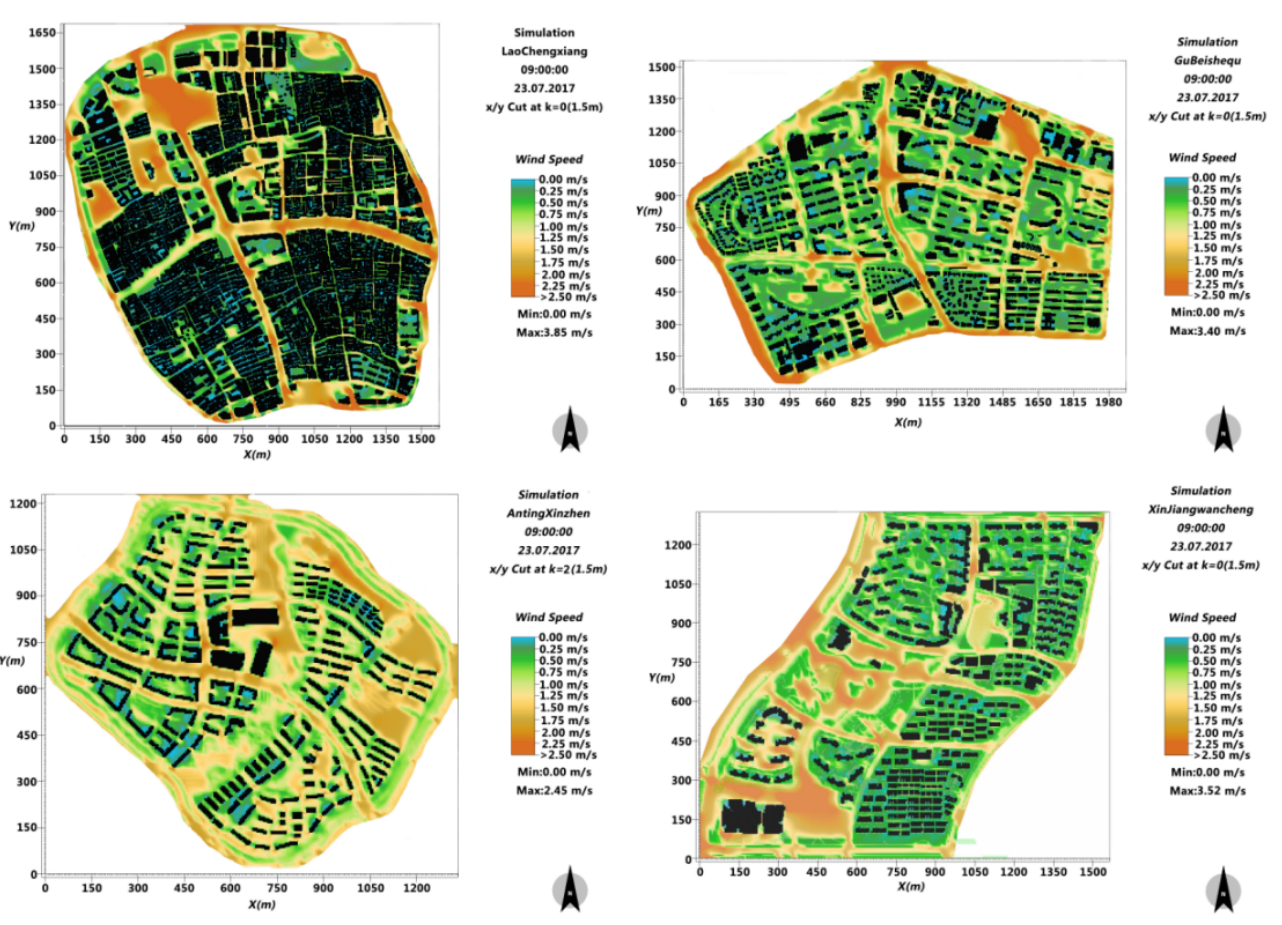
Figure A2. Spatial distribution of the wind speed in the four areas at 9:00 p.m., 1.5 m ( left upper : Old downtown; right upper : Gubei international community; left lower : Anting New Town; lower right : New Jiangwan Town).